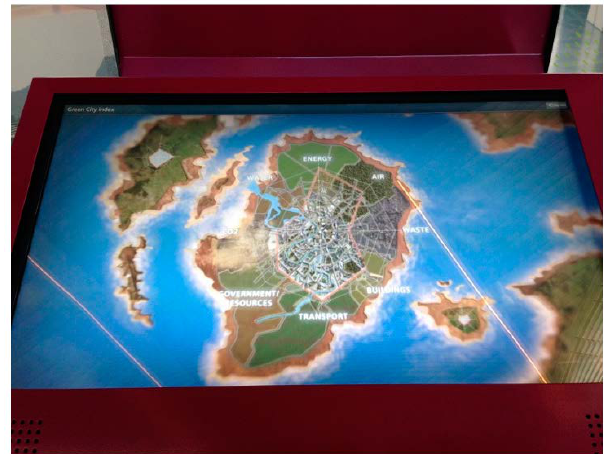
The interface of the Green City Index installation in The Crystal’s urban exhibition (Source: author,